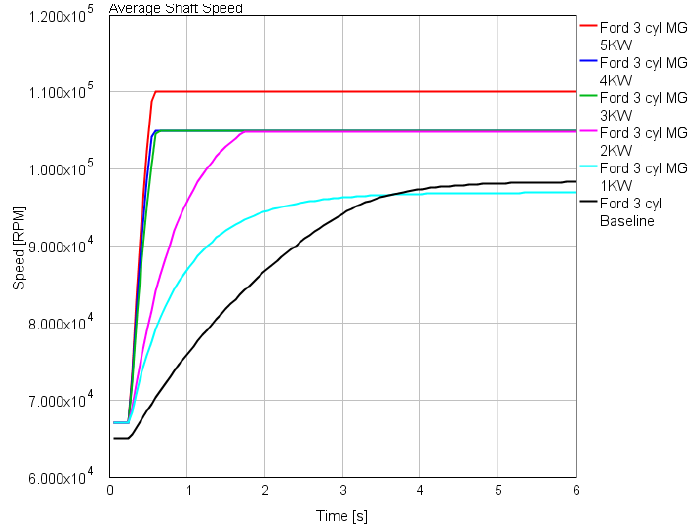
Figure 13. Turbocharger shaft speed at the 2000 rpm engine speed.